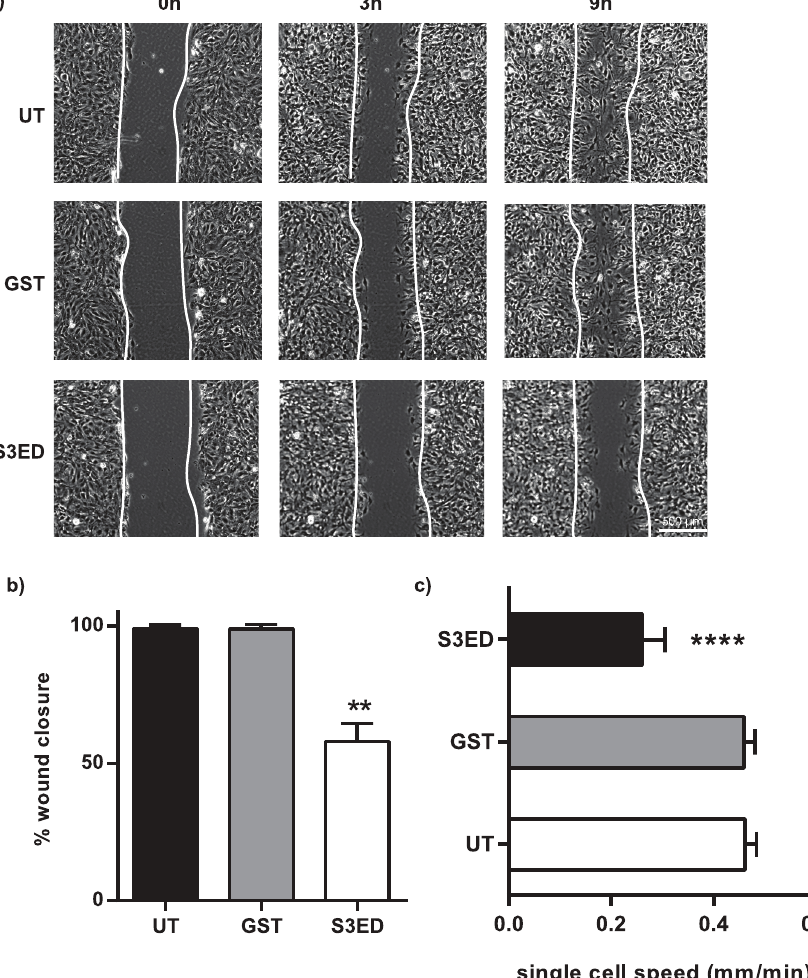
Figure 5. S3ED inhibits brain EC migration. Scratch wounds were made to confluent monolayers of bEND3.1 cells and micrographs were captured after 9 hours clearly showing that wound closure is reduced in the presence of S3ED 0.5 µM ( a ). Scratch wound closure ( b ) and single cell speeds ( c ) were calculated. Single cell speed was calculated from 15–25 cells per condition. Error bars represent SD for ( a ) and SED for ( b ). One-way ANOVA with Bonferroni multiple comparisons was used to compare S3ED to relative UT